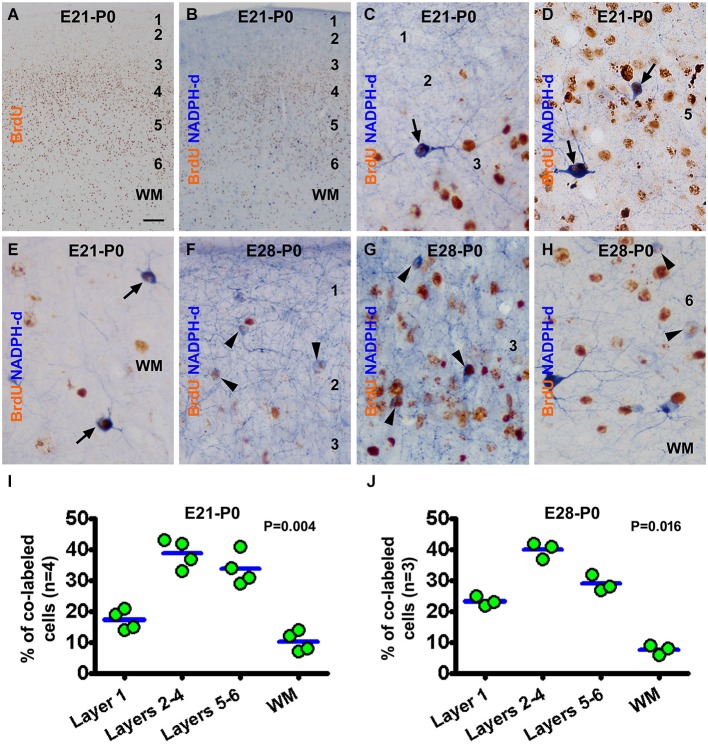
Representative images and quantitative laminar analyses showing bromodeoxyuridine (BrdU) labeling and colocalization in NADPH-d neurons in neonatal guinea pig neocortex following pulse-chasing at embryonic day 21 (E21) and E28. Panel (A) shows the distribution of BrdU immunoreactive nuclei largely in the middle layers of the neocortex in the E21-P0 group. Panel (B) illustrates a low power view of BrdU and NADPH-d dual staining. The remaining panels are high power views of BrdU/NADPH-d colocalized neurons in different cortical layers as marked, from the E21-P0 (C–E) and E28-P0 (F–H) groups. Examples of double labeled type I and type II cells are pointed by arrows and arrowheads, respectively. Dot graphs (I,J) show the laminar distribution of colabeled type I and type II neurons among the groups, with each dot representing the mean of an individual animal. The colabeled cells are present differentially (P = 0.004 by Kruskal-Wallis) between the laminar sectors. Arab numbers: cortical layers, WM: white matter. Scale bar = 100 μm in (A) applying to (B), equivalent to 10 μm for other image panels.